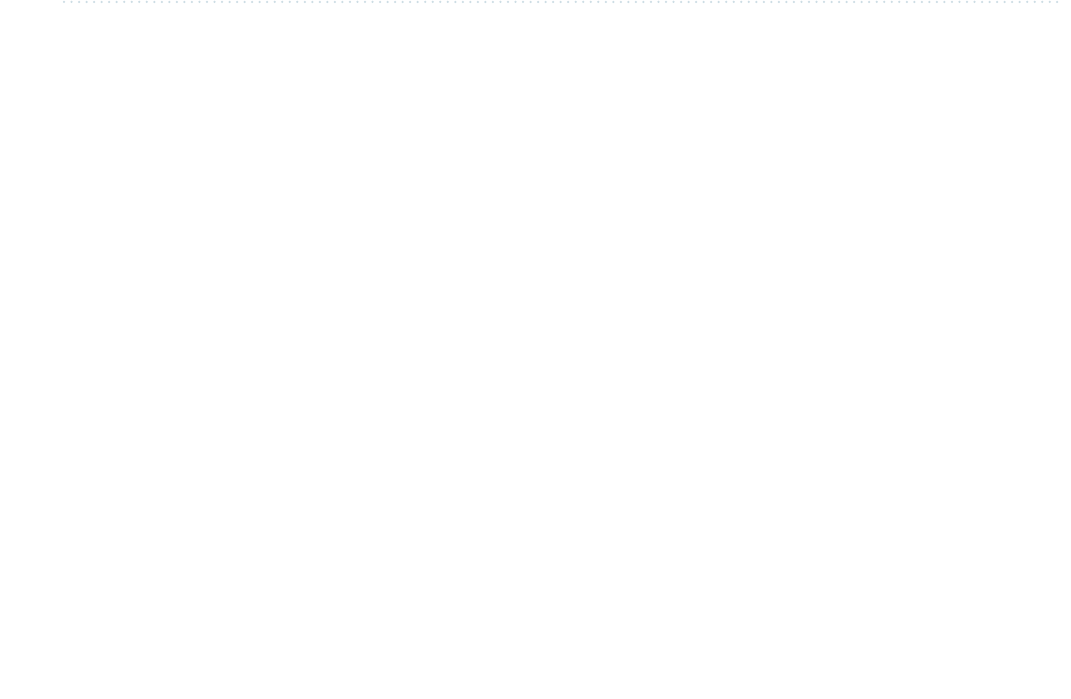
Figure 11. Deformation distribution of the three models under four working